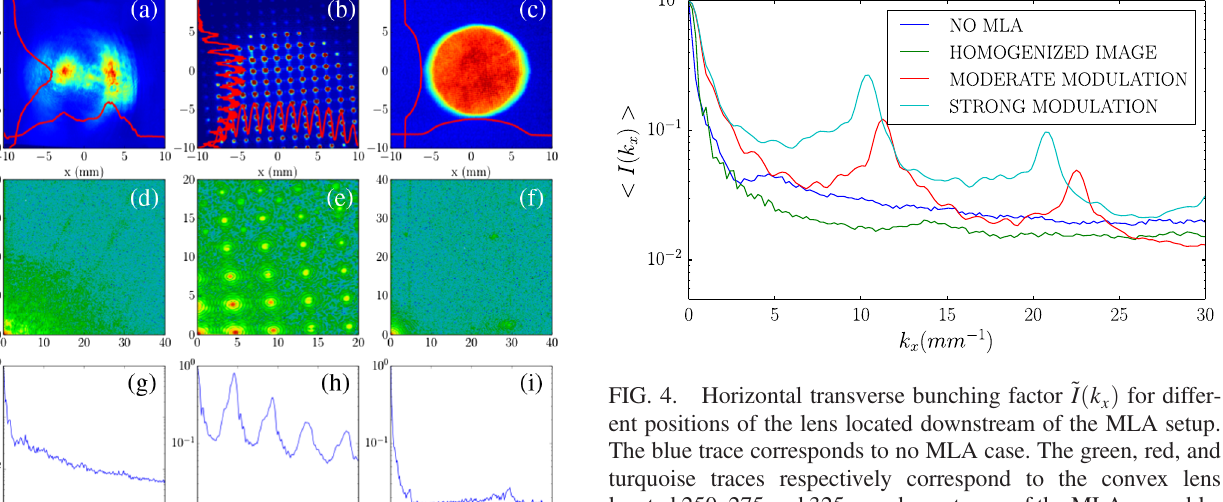
FIG. 4. Horizontal transverse bunching factor ent positions of the lens located downstream of the MLA setup. The blue trace corresponds to no MLA case. The green, red, and turquoise traces respectively correspond to the convex lens located 250, 275 and 325 mm downstream of the MLA assembly.